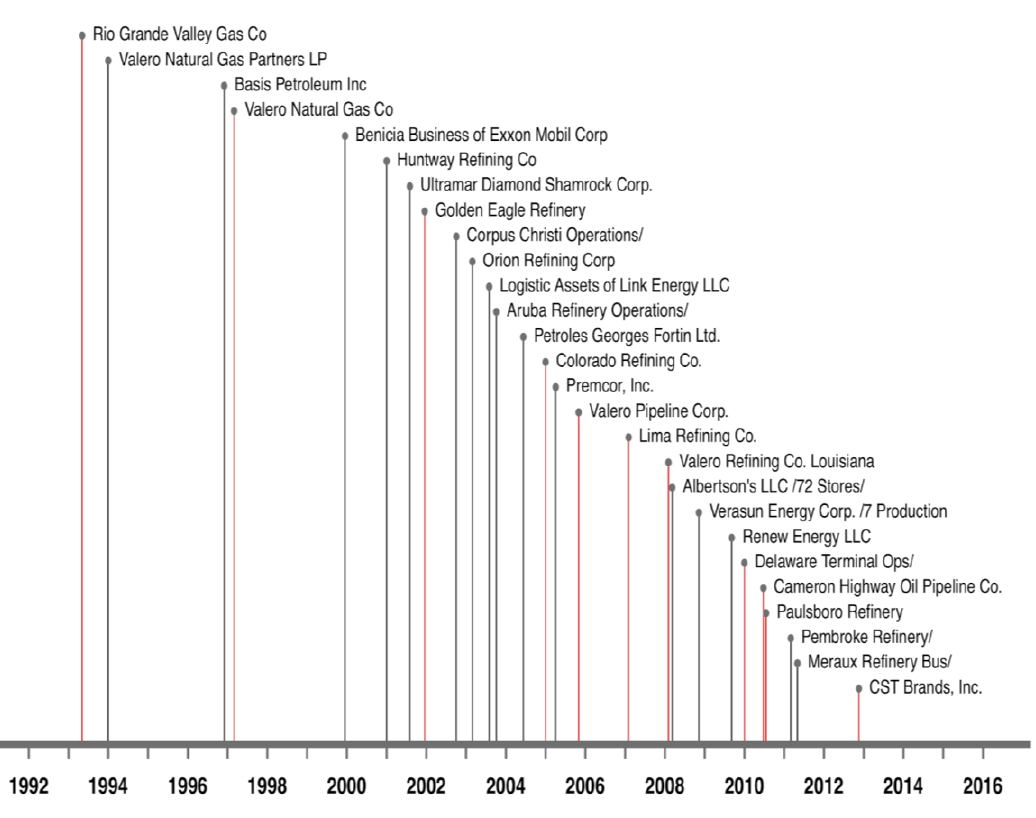
Figure 3: Acquisitions (black lines) and Divestitures (red lines) - Valero (1993–